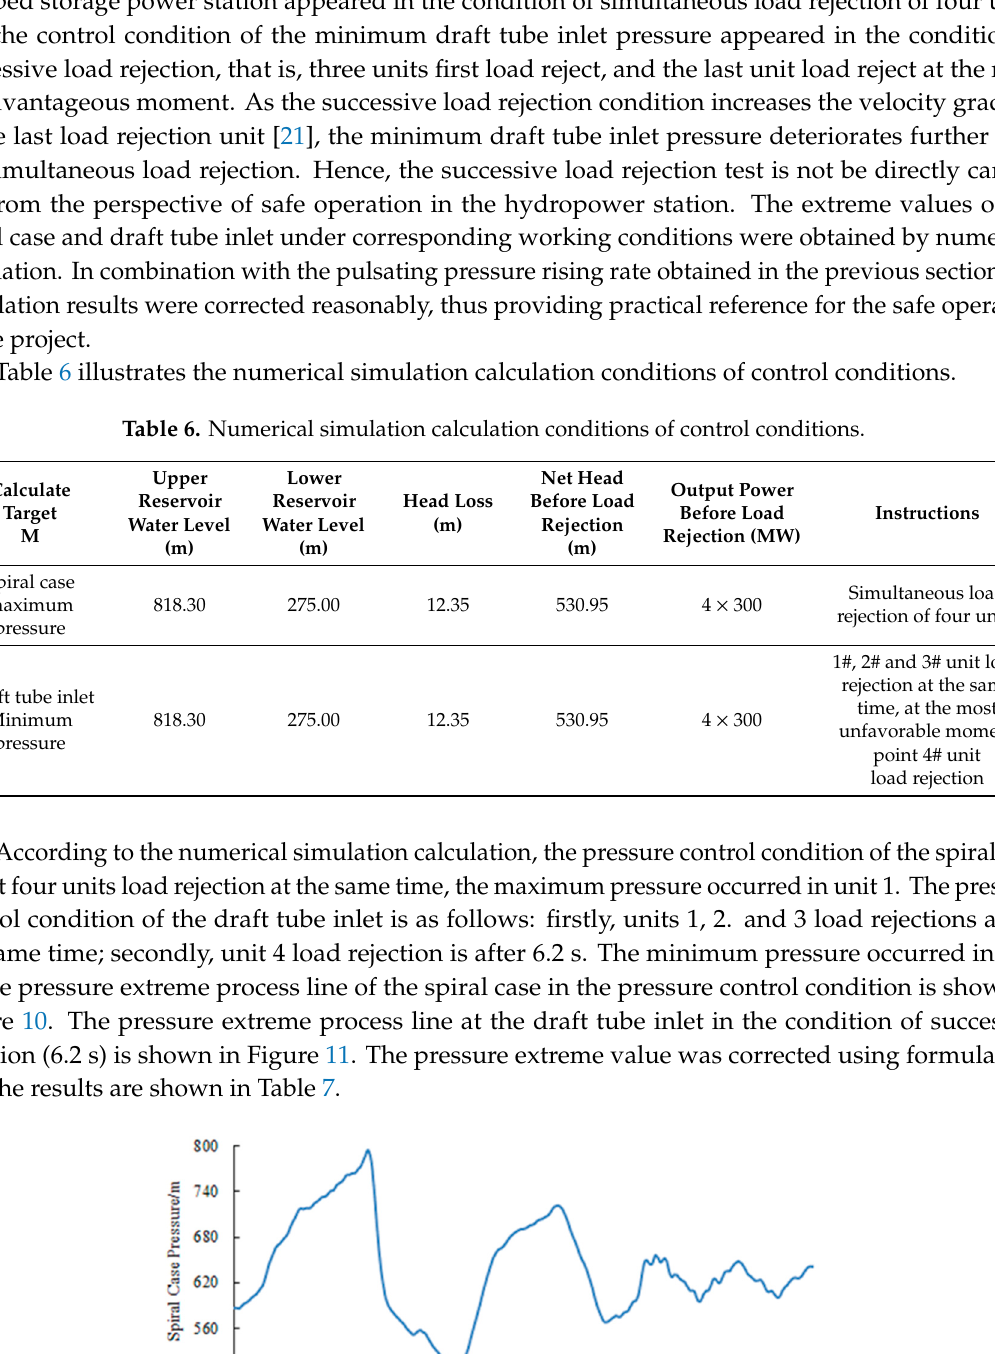
Figure 11. Pressure extreme process line of draft tube inlet under successive load rejection. Table 7. Extremum of control conditions.